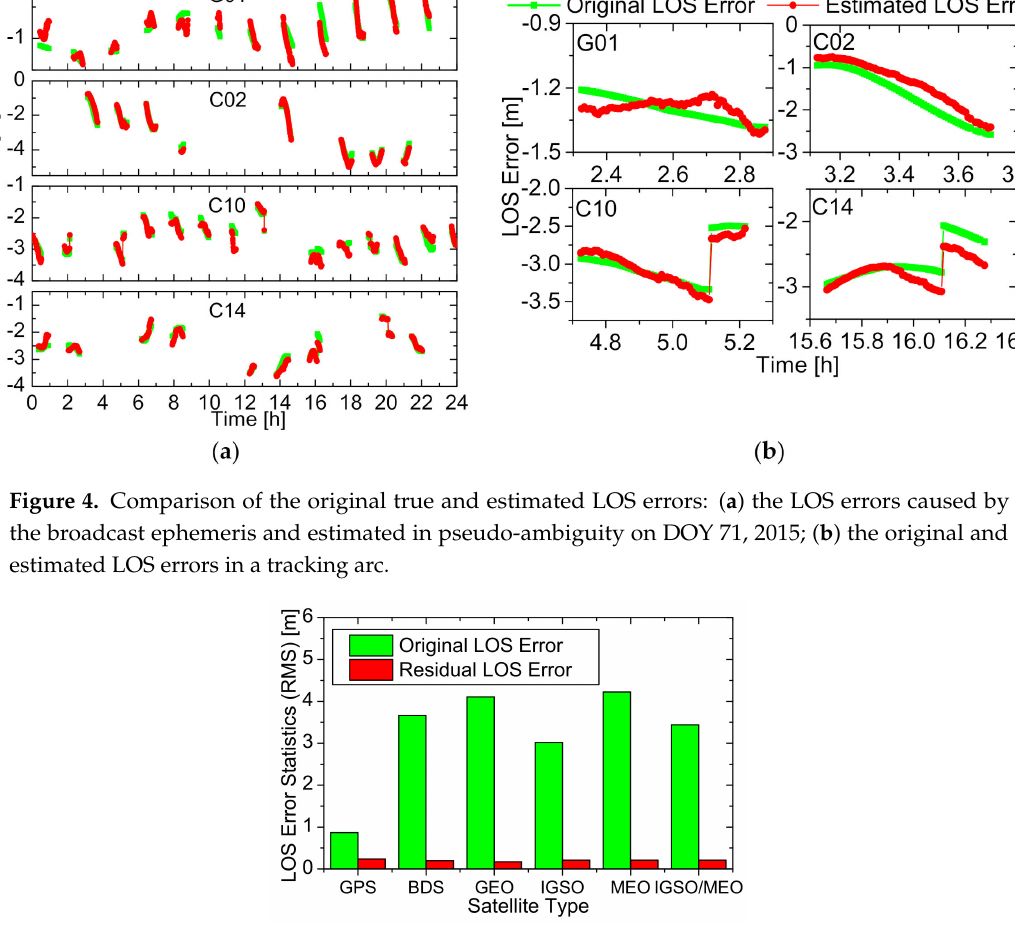
Figure 5. Comparison of original and residual LOS errors